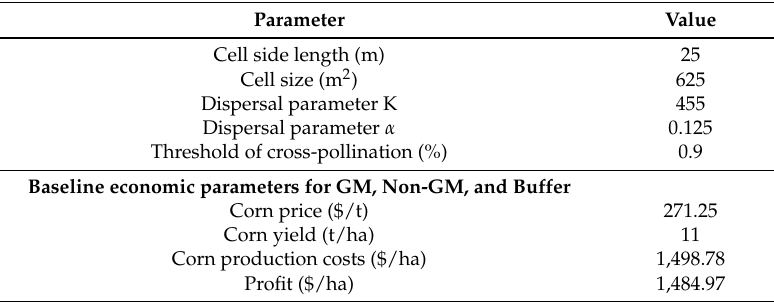
Table 1. Parameters defining the spatial baseline of analysis. (GM, genetically